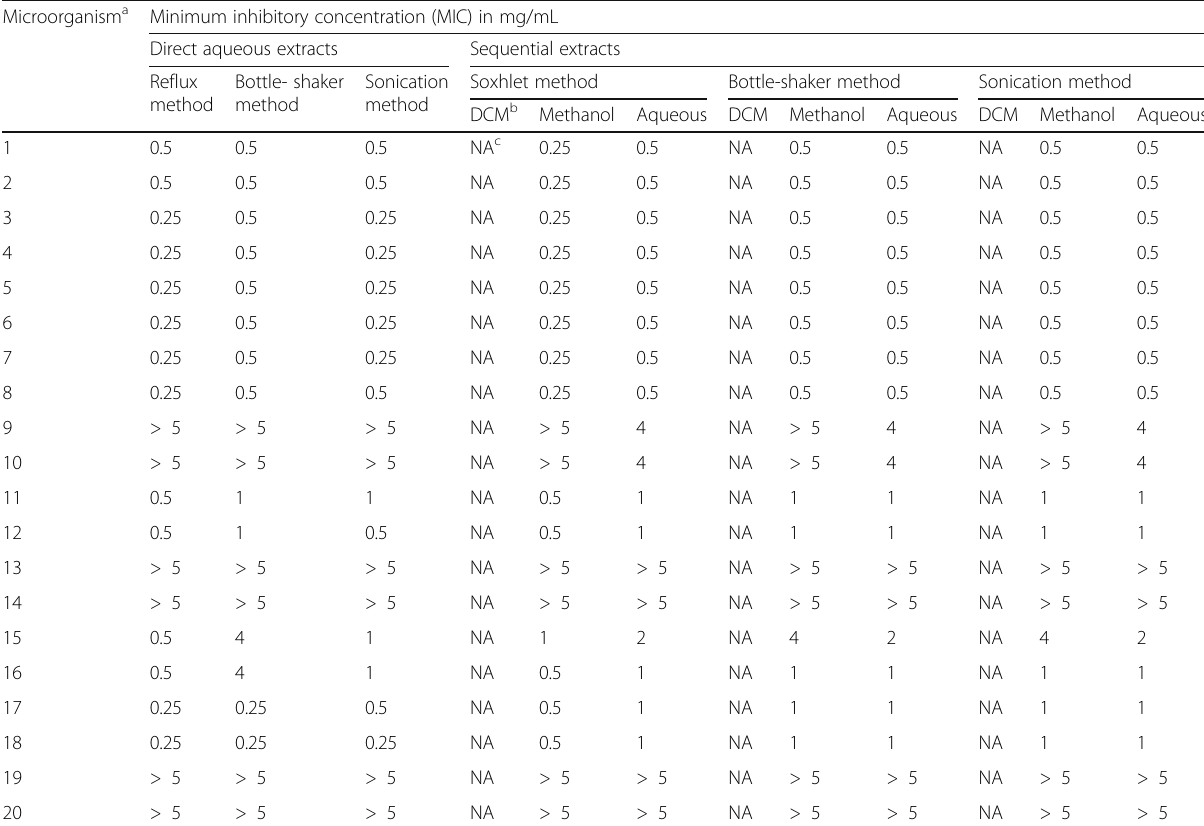
Table 1 Minimum inhibitory concentration values (MIC) of Terminalia bellirica fruit extracts obtained by different extraction methods, against 16 MDR strains (from clinical isolates), 1 ATCC MDR strain and 3 ATCC susceptible strains Microorganism a Minimum inhibitory concentration (MIC) in